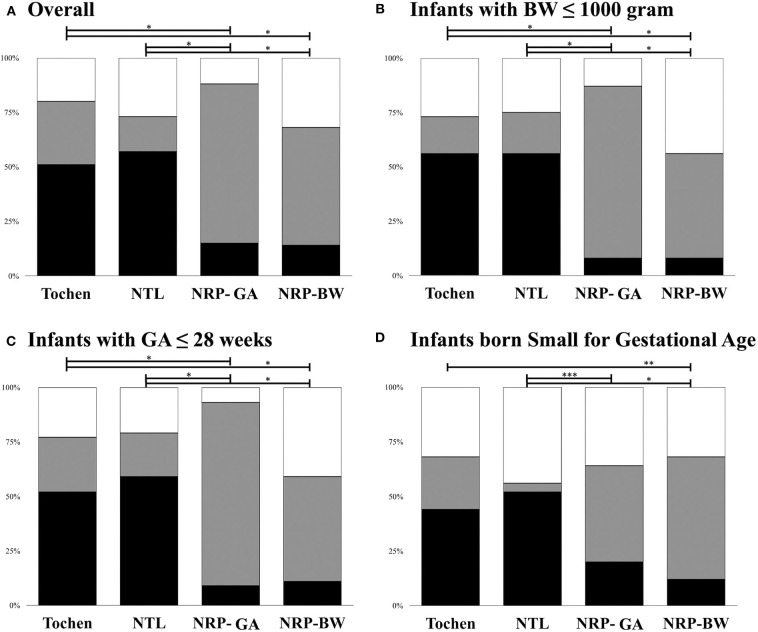
Positioning of the endotracheal tube tip in relation to the mid-trachea using TF, NTL, and NRP intubation length recommendations. (A) For all participants; (B) For infants with very low birth weight; (C) For infants born before completion of 28 weeks of gestational; (D) For infants born small for gestational age. Black: concordant with mid-trachea. Gray: shallower than mid-trachea. White: deeper than mid-trachea. TF, body weight + 6 cm; NTL, Nasal Tragus Length + 1 cm; NRP, Neonatal Resuscitation Program; NRP-GA, NRP Intubation Length Recommendation by Gestational Age; NRP-BW, NRP Intubation Length.ShadingExplanation■Concordant with mid-trachea■Shallower than mid-trachea□Deeper than mid-trachea